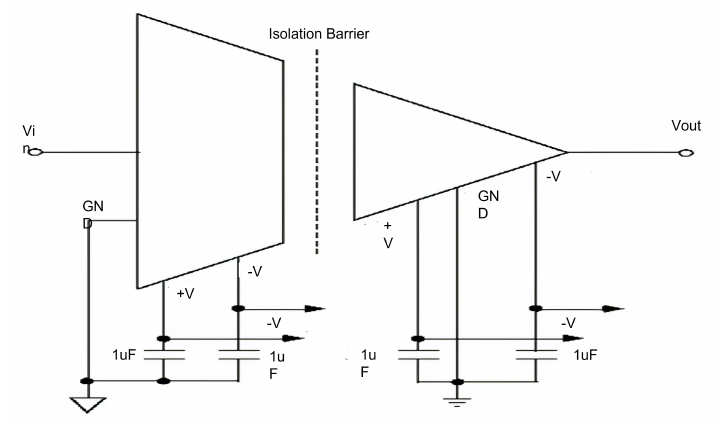
Figure 9. Isolation module using the IC ISO122 that generates a modulation–demodulation process using electrolytic capacitors of 1 µ F.